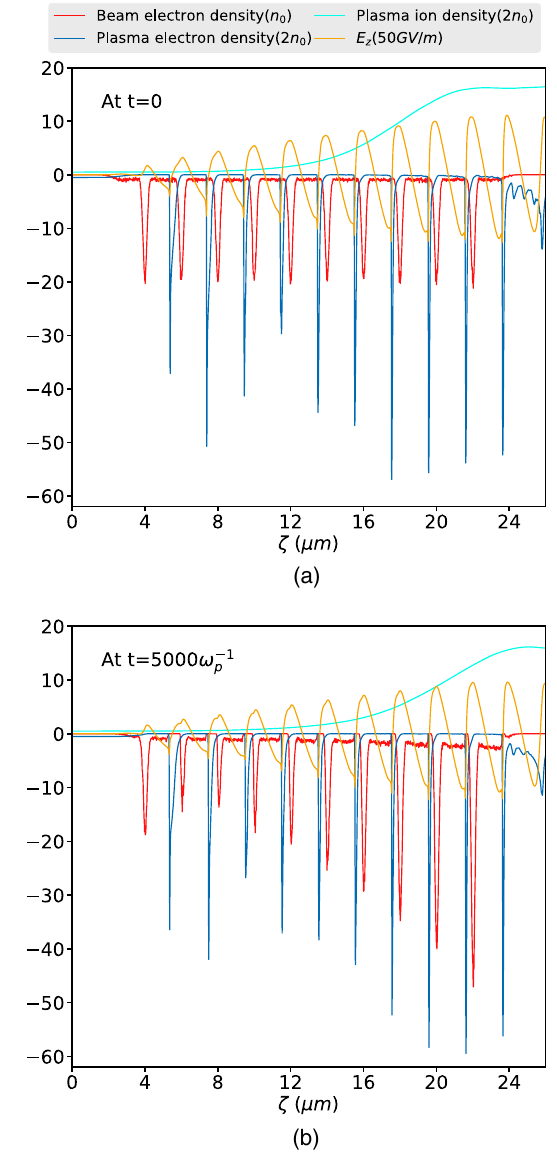
FIG. 6. Beam charge density, plasma density, and longitudinal electric field of a partially bunched system (ratio between peak and flat region ≈ 20 ) initially (a) and after t ¼ 5000